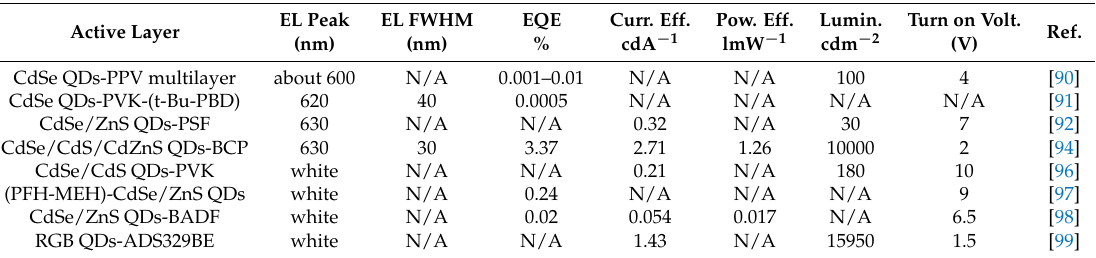
Table 2. Performances of the hybrid light emitting diodes (LEDs) described in the text. Active Layer CdSe QDs-PPV